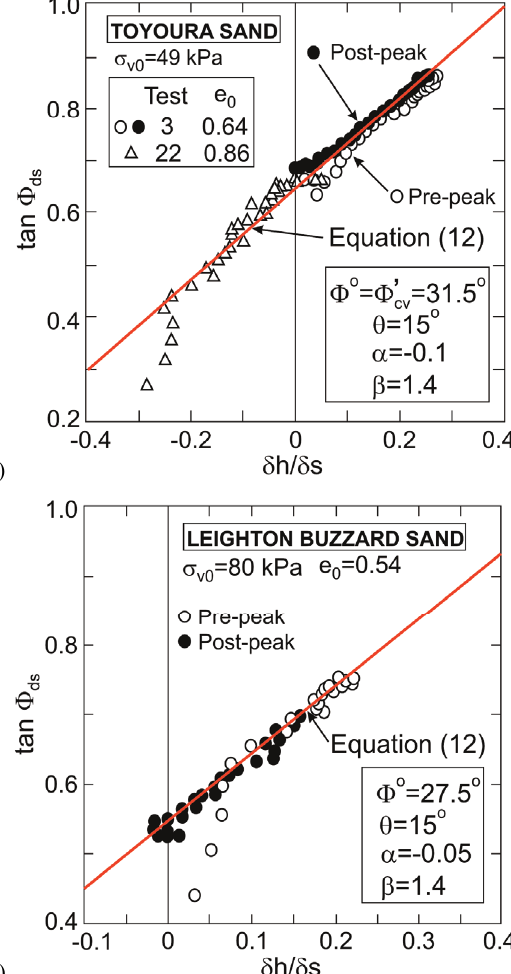
Fig. 7. Relationship between the stress ratio and dilatancy: (a) Toyoura sand; (b) Leighton Buzzard sand For the notations used in this paper, tan  and tan  =  h /  s . Very good approximations of the experimental data were obtained for the pre-peak and post-peak stages using equation (12) with  o = 31.5 